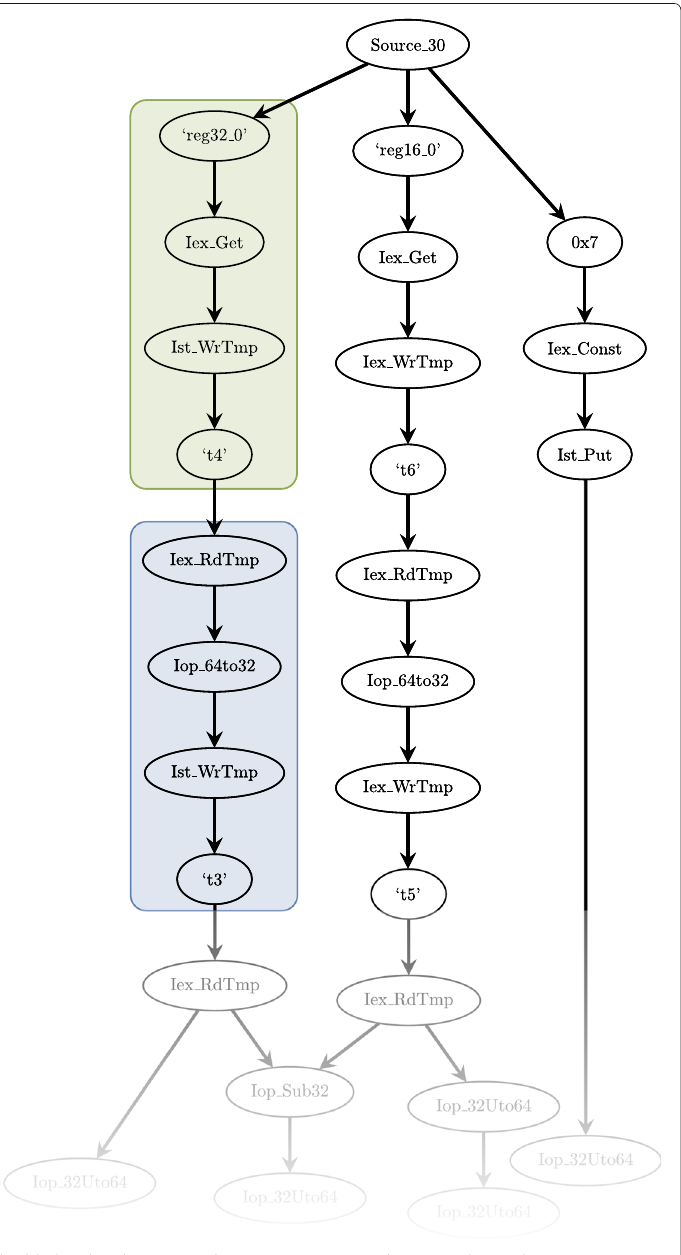
every constant, and chains of Iex_WrtTmp → ‘t%’ → Iex_RdTmp 1 . This is demonstrated in Fig.